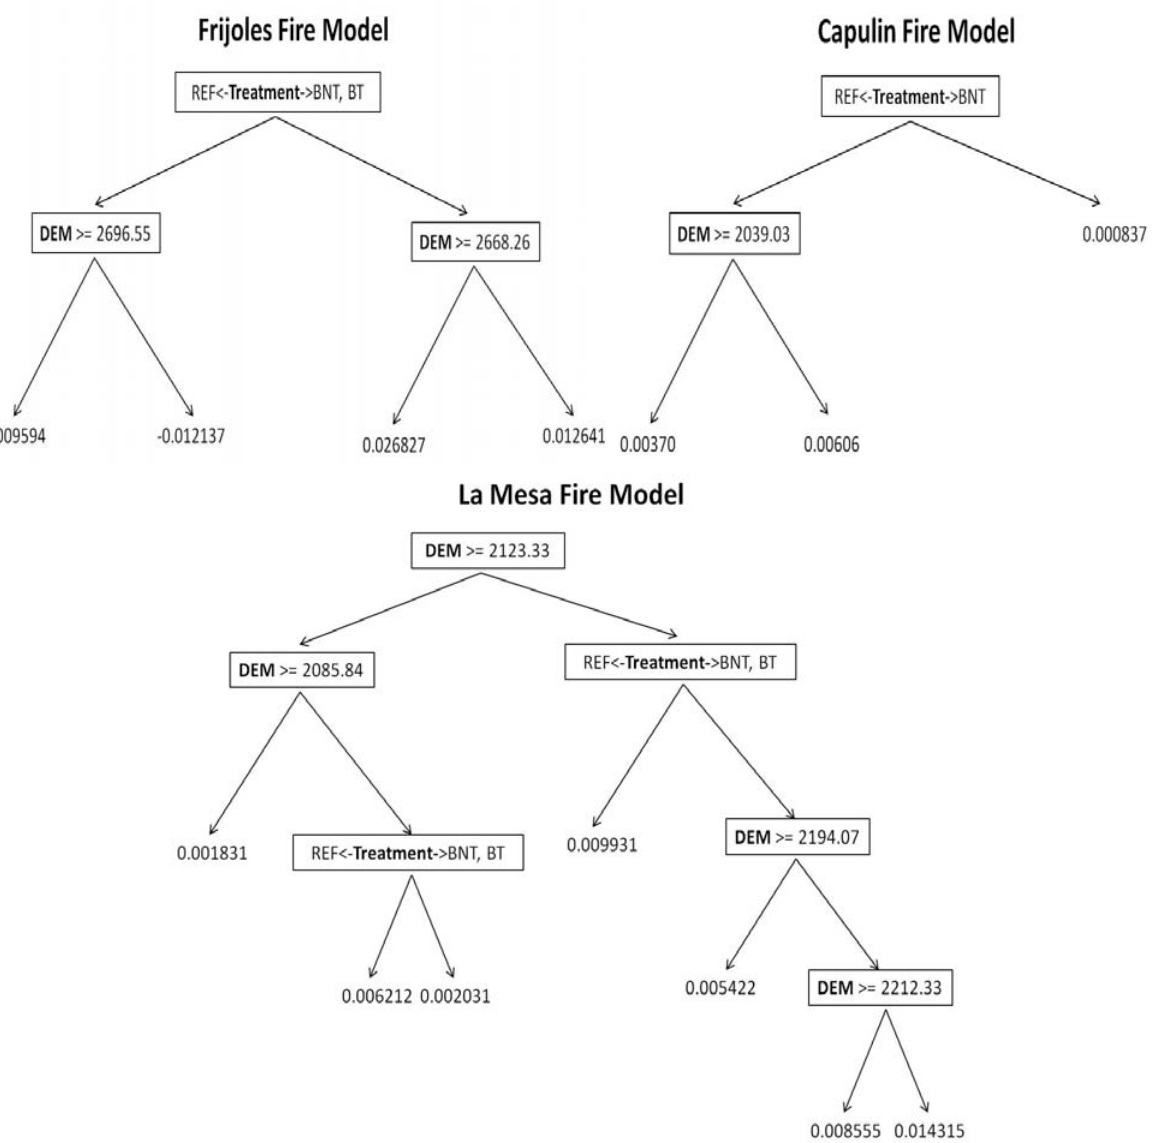
Figure 8. The regression tree models for post-fire NDVI with the optimal pruning level [45] are shown for the three fires that were evaluated. The rectangles represent the nodes with the variable responsible for the split. In the case of treatments the reference areas (REF), the pre-fire treated burned areas (BT), and the untreated burned areas (BNT) were represented as qualitative